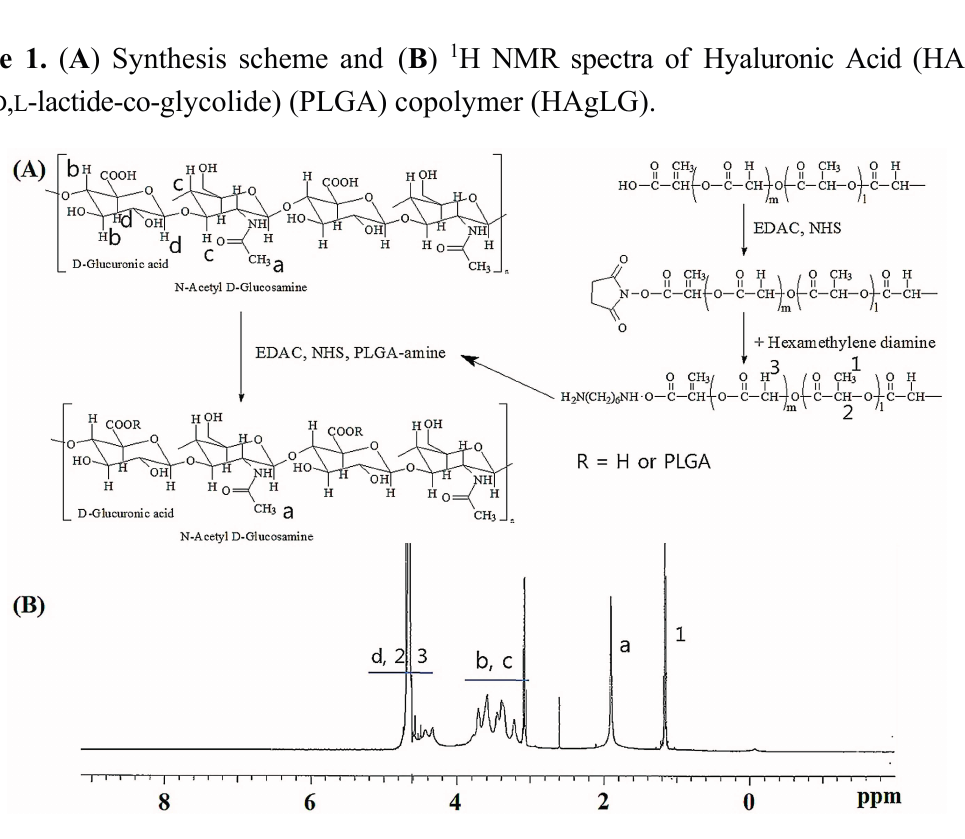
Table 1. Characterization of HAgLG polymeric